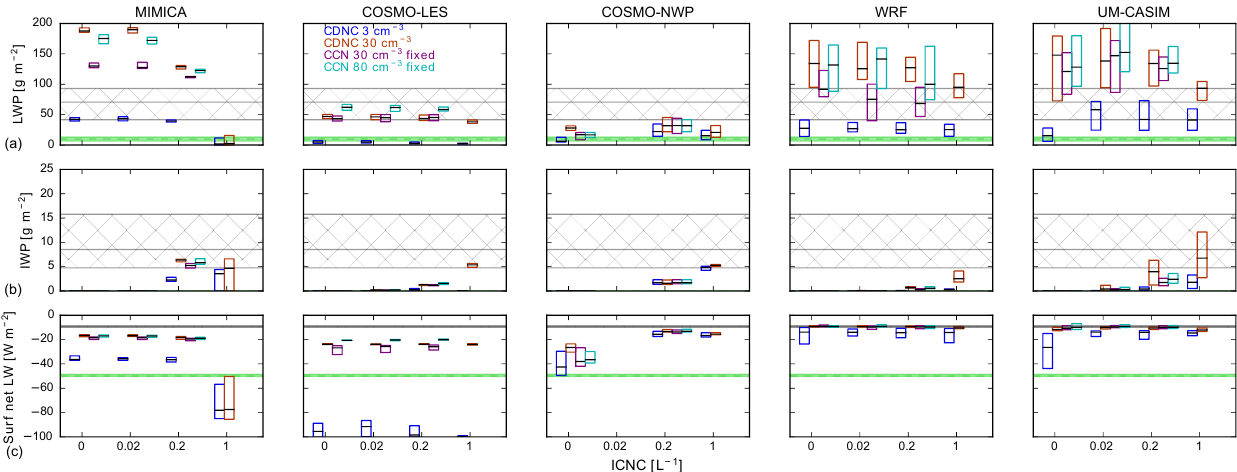
Figure 14. Water paths and net longwave radiation for all simulations without aerosol processing. (a) Liquid water path, (b) ice water path, (c) surface net longwave radiation. Each subplot shows results from a single model. From left to right: MIMICA, COSMO-LES, COSMO- NWP, WRF, and UM-CASIM. Simulations with prescribed CDNCs of 3 (CDNC03) and 30cm − 3 (CDNC30) are shown as blue and red boxes, respectively, and simulations with prescribed CCN concentrations of 30 (CCN30fixed) and 80cm − 3 (CCN80fixed) are shown as purple and turquoise boxes, respectively. Within each subplot, the ICNC is increased from left to right as 0, 0.02, 0.2, and 1L − 1 . Boxes show the interquartile range over model results after 31 August 12:00UTC, and the black horizontal lines denote the medians. Hatched regions indicate observed interquartile range for the cloudy period, and the green shaded regions indicate the range for the nearly cloud-free